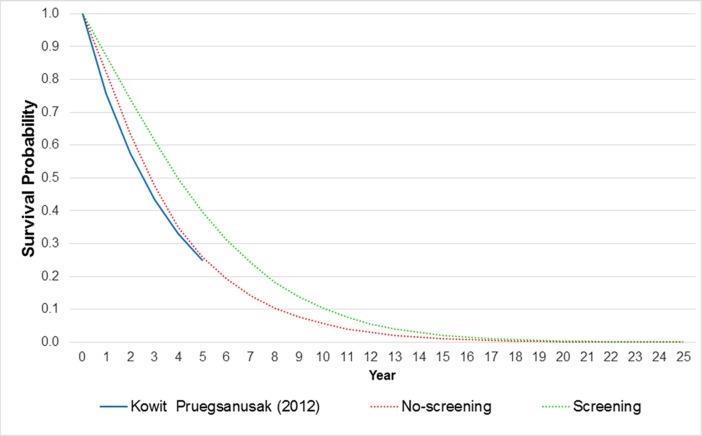
Model validation.